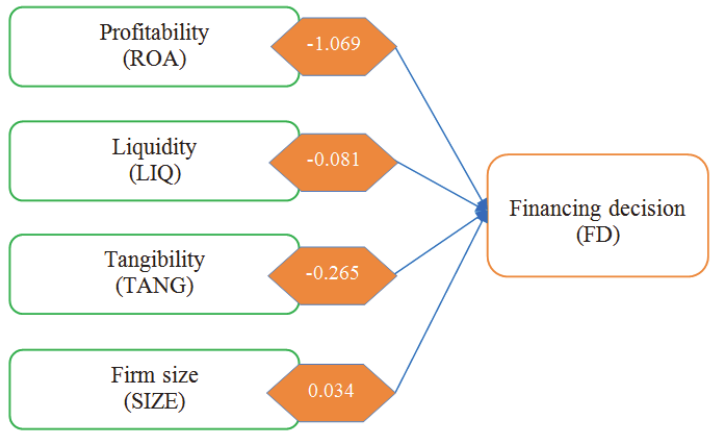
Fig. 1 . Study model results